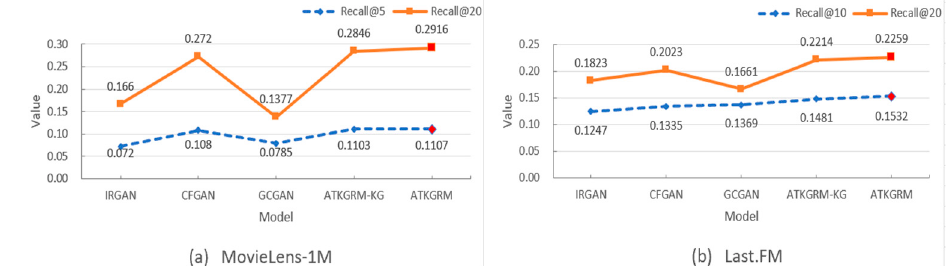
Figure 4. Comparison results of adversarial training recommendation models. (On two different datasets).